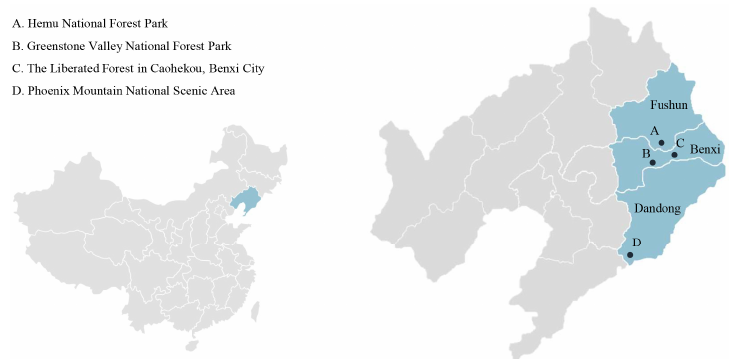
Figure 1. Locations of the study sites. A: Hemu National Forest Park has a total area of 13.68 square kilometers. The environmental quality in the park is good, and the vegetation coverage rate is high. There are natural secondary forests and plantations. B: Greenstone Valley National Forest Park covers an area of approximately 20 square kilometers, with undulating terrain and diverse vegetation. It is a typical mountain-type forest park. C: The Liberation Forest in Caohekou, Benxi City, has 0.22 square kilometers of artificially planted Korean pine forest; it is the first artificially built Korean pine forest in China. D: Phoenix Mountain National Scenic Area covers an area of approximately 216 square kilometers, with high mountains and forests, waterfalls and springs, and rich dynamic water space. It is a typical scenic area in eastern